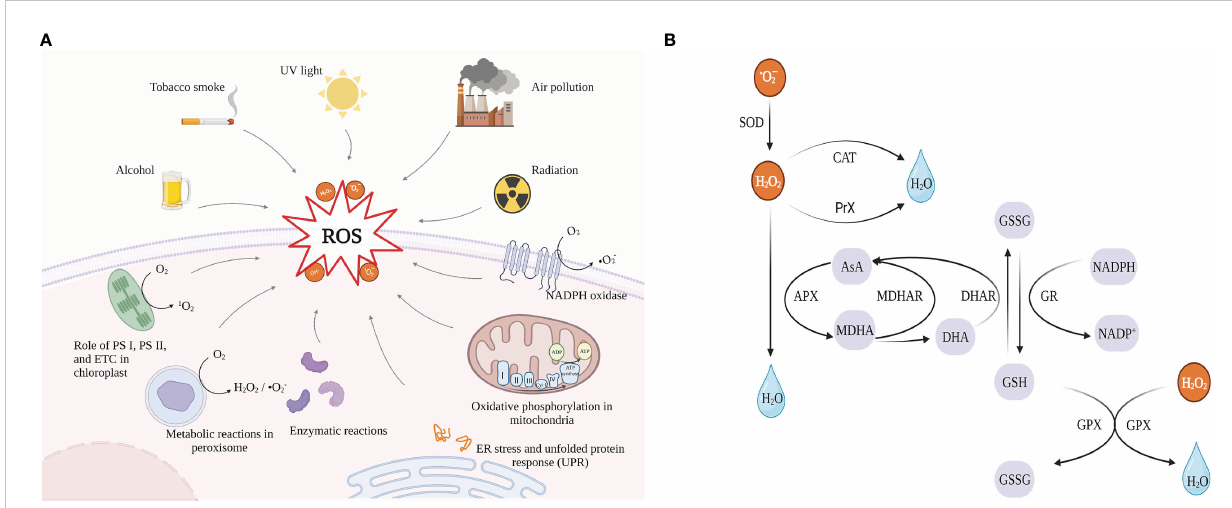
FIGURE 6 (A) Sources of reactive oxygen species (ROS), created with https://biorender.com/ (accessed on 24 December 2022); (B) combined mechanisms of enzymatic and non-enzymatic antioxidants. SOD, Superoxide dismutase; CAT, Catalase; PrX, peroxiredoxin; APX, Ascorbate peroxidase; AsA,